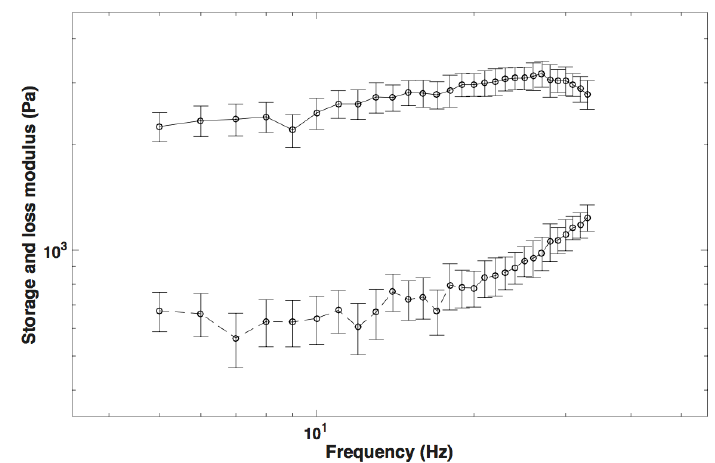
Figure 11. The storage and loss shear modulus measured by rheometry in cervical